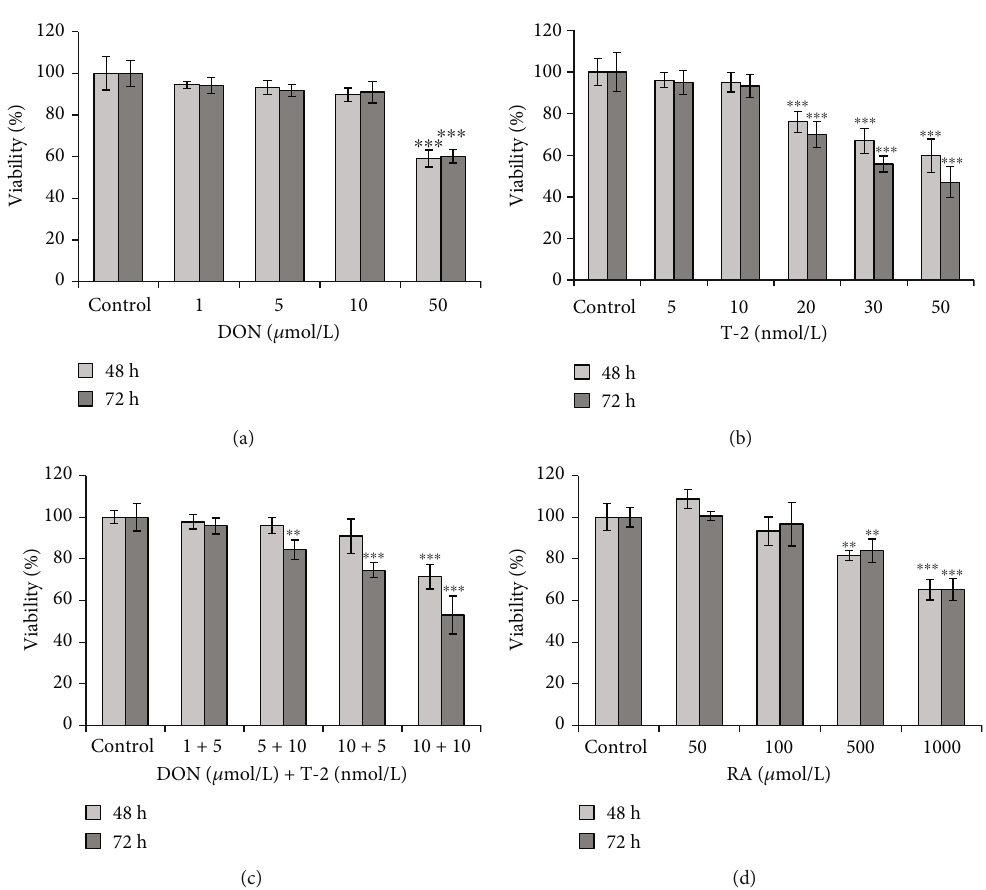
Figure 2: E ff ects of (a) DON, (b) T-2, (c) DT2, and (d) RA on viability % of the di ff erentiated IPEC-J2 cells measured by NR assay. Incubation times were 48h and 72h. Signi fi cant di ff erences were found between untreated samples and cells exposed to 50 μ mol/L DON or 20 nmol/L T- 2. In the case of DT2 treatment, addition of 1 μ mol/L DON and 5 nmol/L T-2 to IPEC-J2 cells did not in fl uence cell viability signi fi cantly for 48h and 72 h. RA appeared to be cytotoxic at higher concentrations (at 500 and at 1000 μ mol/L). Data are presented as viability % means ± SDs ( n = 8 , ∗∗ p < 0 : 01 and ∗∗∗ p < 0 : 001